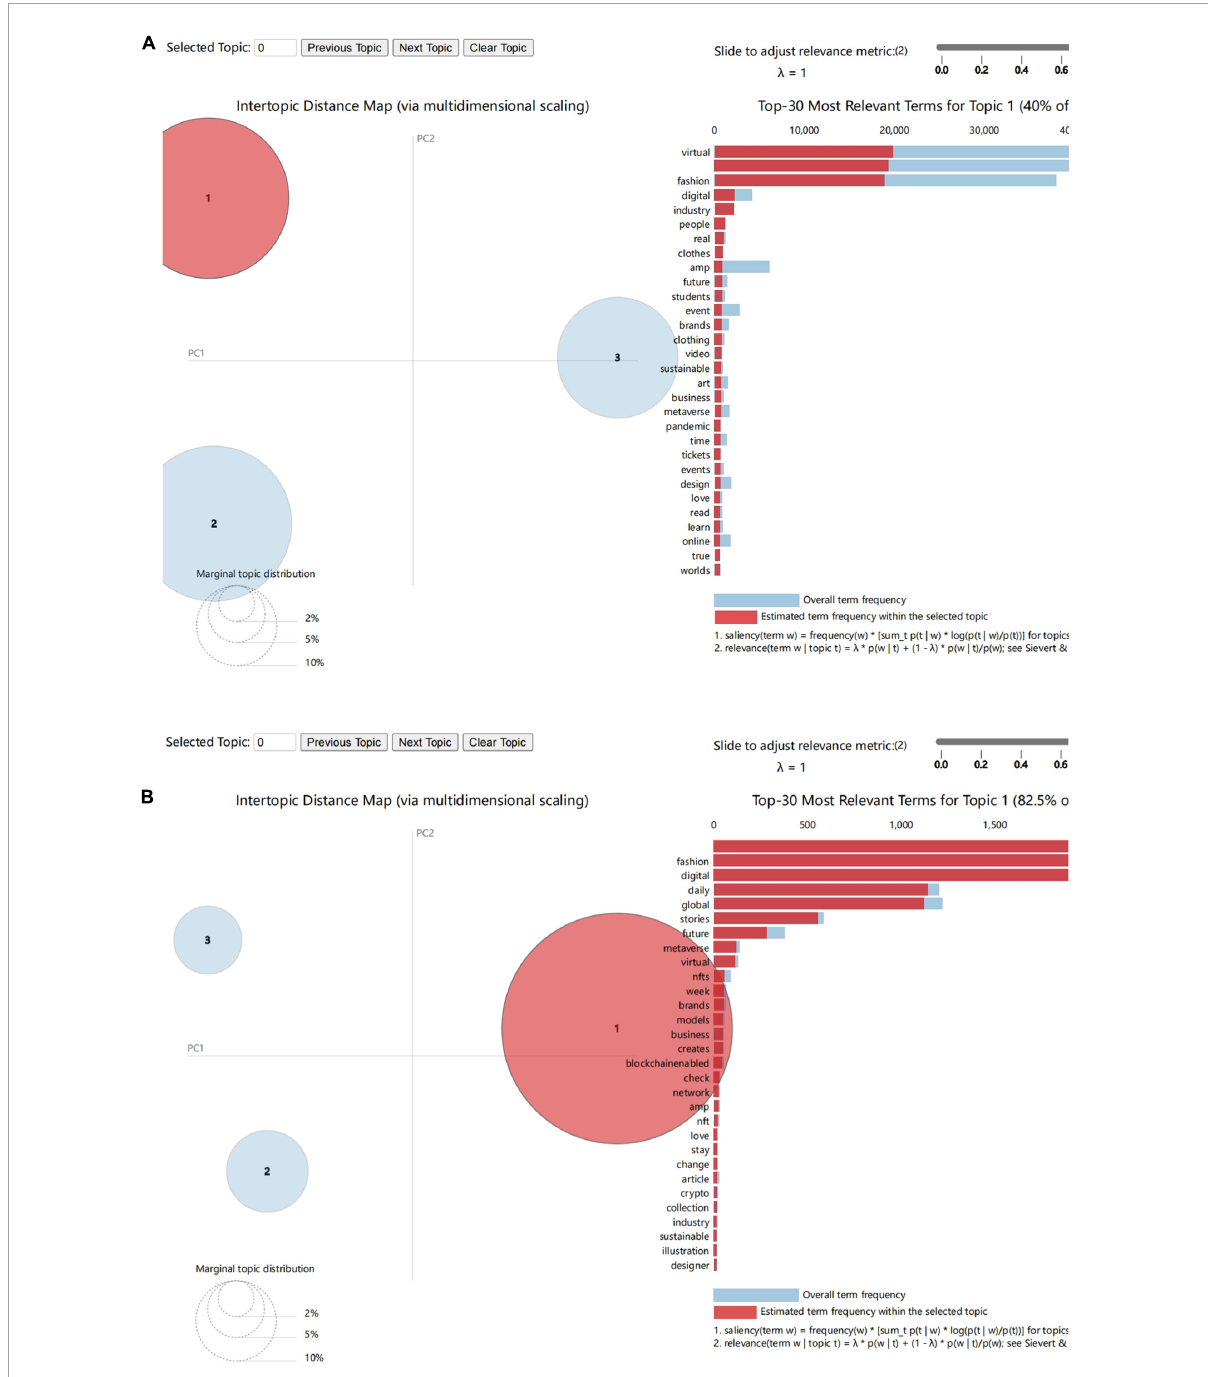
FIGURE4 (A) Topic modeling for the first cluster class. (B) Topic modeling for the second cluster class.